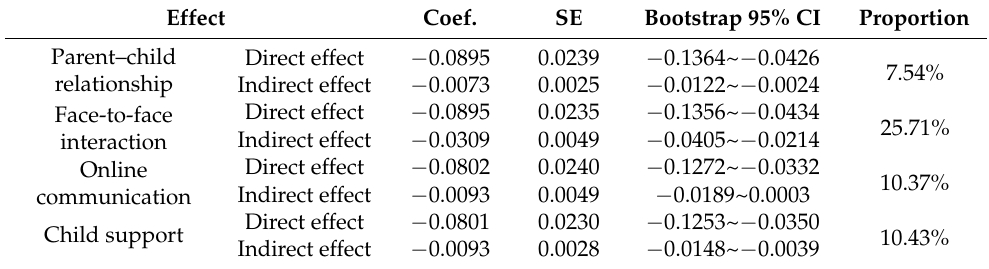
Table 6. Bootstrap mediation